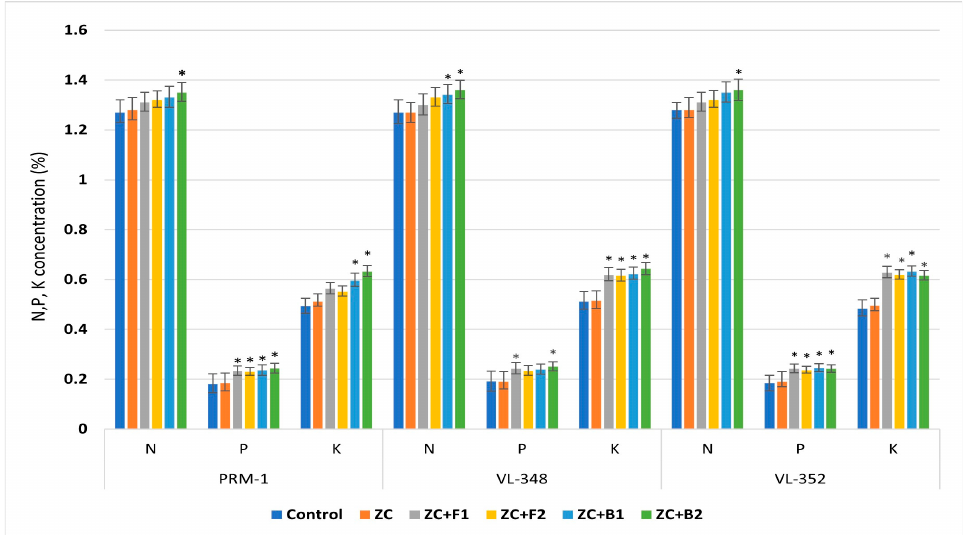
Figure 8. Endophyte inoculation influencing grain NPK concentrations. Error bars indicate the mean of triplicate experiments ± standard deviation (ZC—Zinc carbonate; F1—EC1F-15; F2—EC1F-23; B1—EC3B-22; B2—EC3B-23.) * Indicates significate values at 5% probability.